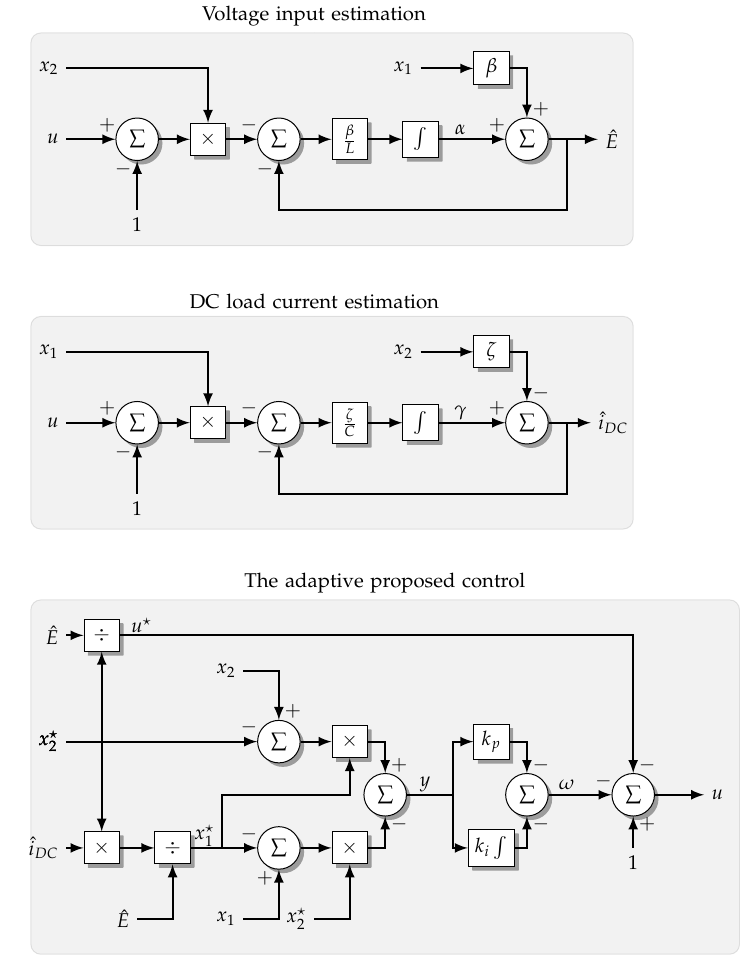
Figure 3. The scheme of the sensorless adaptive PI-PBC